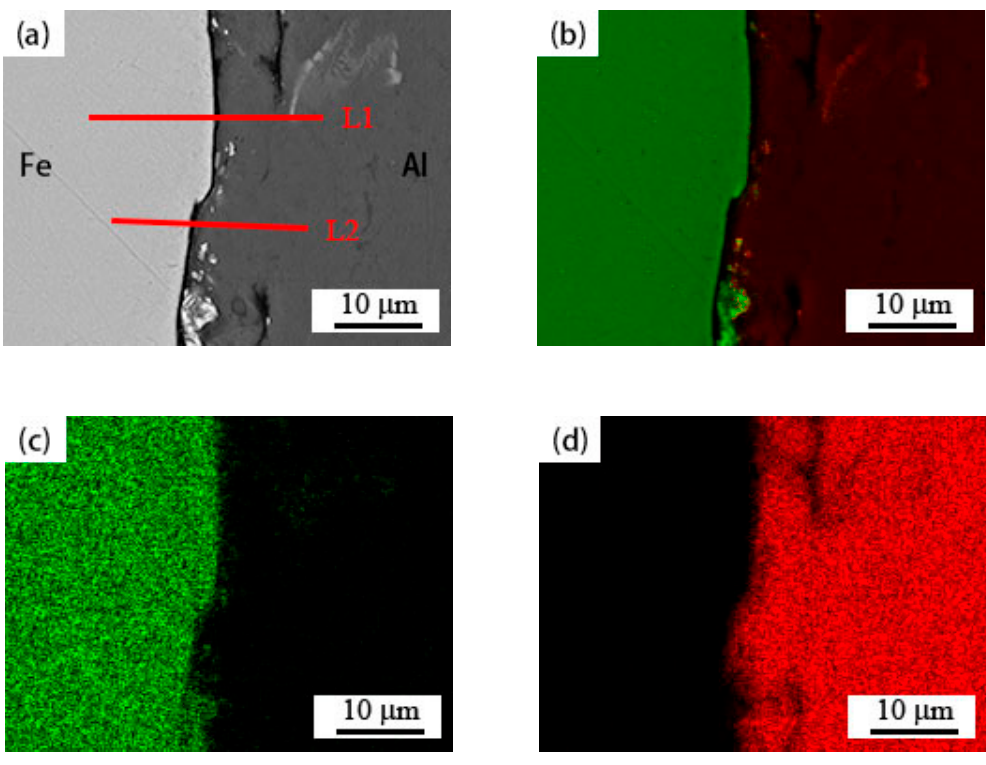
Figure 5. Elemental mapping results of the Al-6061 / Q235a joining interface ( a ) SEM image of the joining interface; ( b ) elemental mappings of the joining interface; ( c ) the elemental distribution of Fe; ( d ) the elemental distribution of Al.